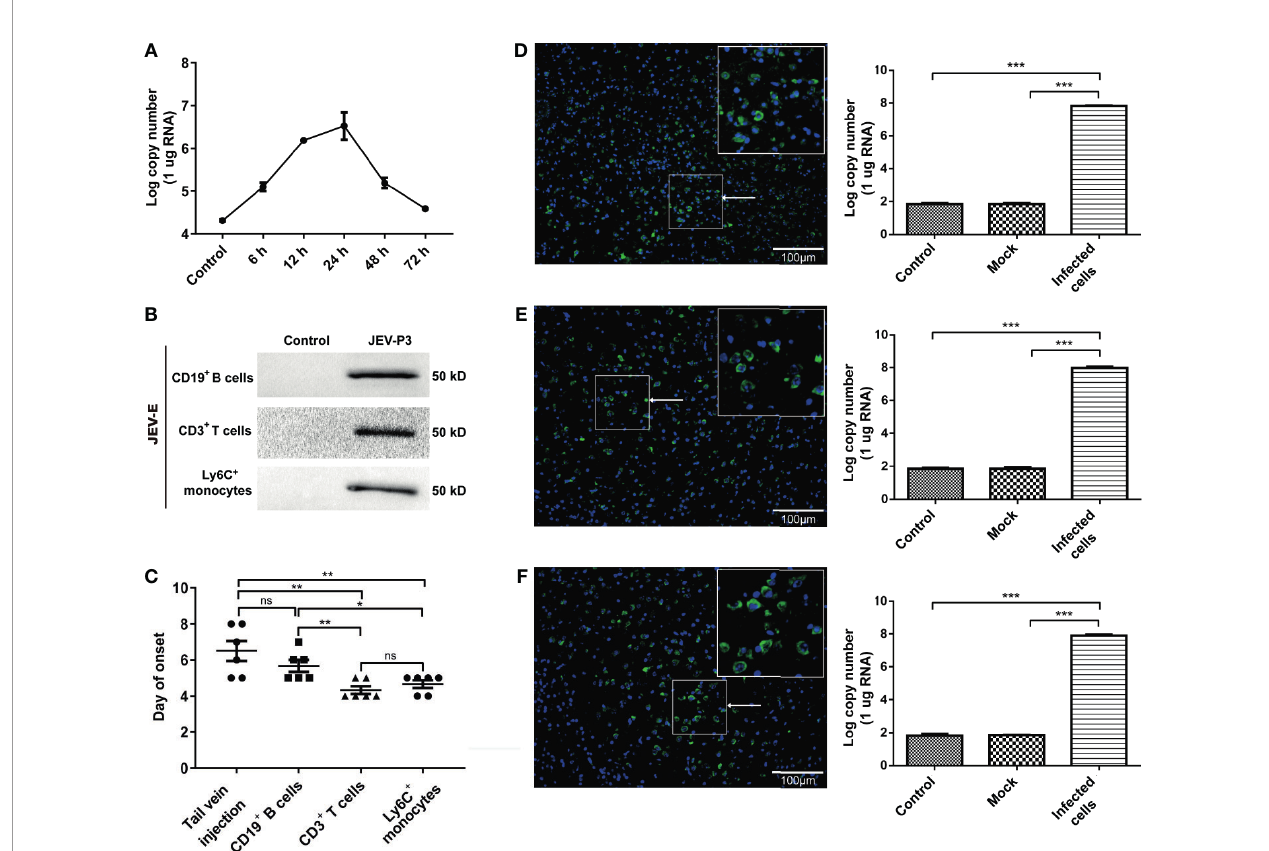
FIGURE 6 | JEV-infectedimmunecellsfacilitatingvirusdisseminationintheCNSwereaf fi liatedwithJEinmice. (A) ThereplicationofJEV inmousesplenocytesfrom 0h (Control) to72hwasmeasuredbyreal-timePCR. (B) Puri fi edCD3 + Tcells,CD19 + B cells, andLy6 + monocyteswereexposedtoJEV-P3, whichwasdetectedbyWestern blottingusingananti-JEV-E proteinantibody. JEVfreecellswereservedascontrol. (C) ThestatisticalanalysisofJEonsetafterJEV-infectedCD19 + Bcells, CD3 + T cells,and Ly6C + monocyteswereinjectedintohealthyadultmicebrains, comparedwiththeJEonsetinthetailveininjectiongroup. Aftertheintracranialinjection ofPBS(Control), JEV- infected(Infectedcells) or uninfected(Mock) Ly6C + monocytes (D) , CD3 + T cells (E) ,andCD19 + Bcells. (F) Immuno fl uorescenceimages oftheJEmicebrains, whichshowed cells stainedfor DNA(blue,DAPI) andJEV(green,JEV-Eprotein). JEVreplicationinmousebrainswasmeasuredbyreal-timePCR.Thescalebar for (D – F) is100 m m.The experimentswererepeatedatleastthreetimes. Thedataareexpressedas themeans ±SEM. p >0.05 (ns, nosigni fi cantdifference), * p <0.05, ** p < 0.01, and*** p